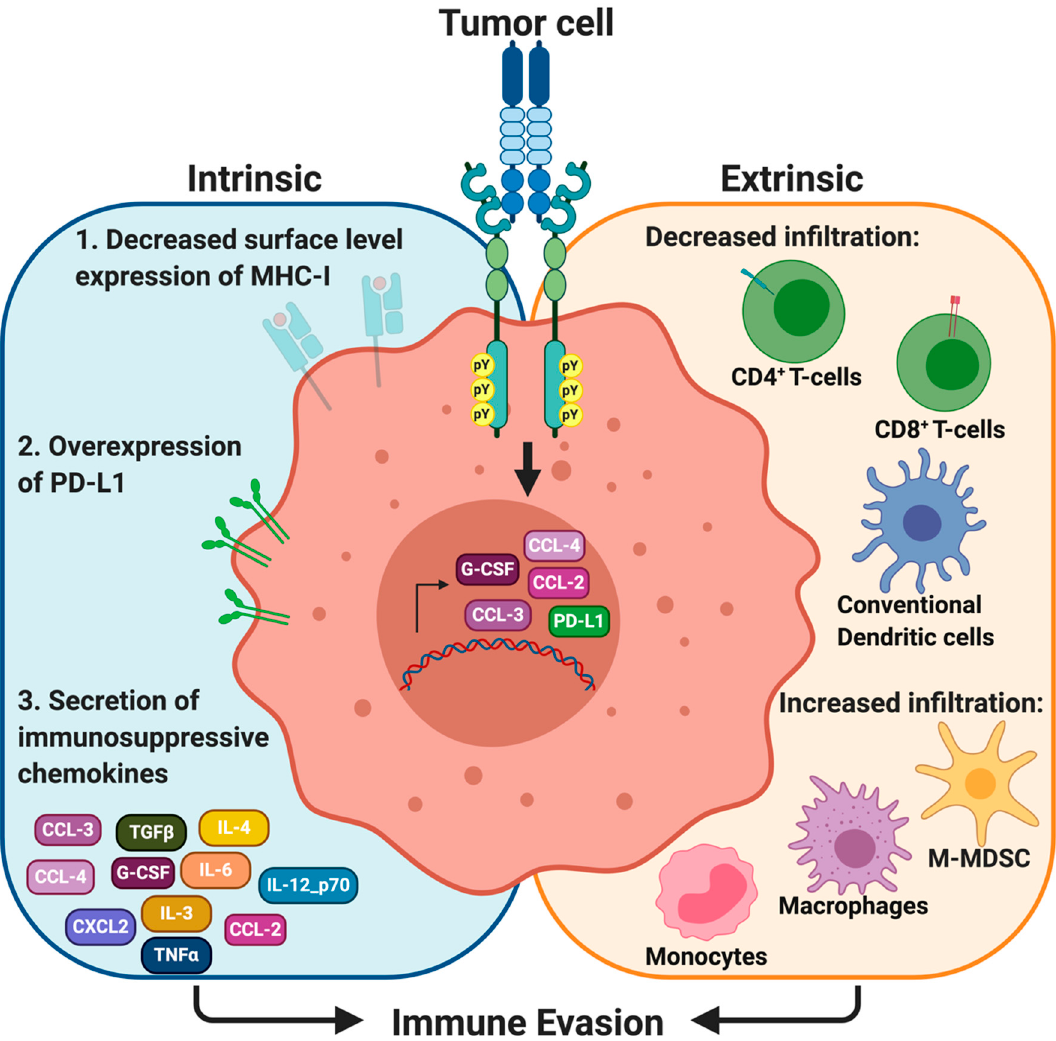
Figure 2. The Gas6 / Axl signaling promotes the immunosuppressive tumor microenvironment. Axl signaling modulates surface level expression of major histocompatibility complex I (MHC-I) and programmed death ligand-1 (PD-L1) on neoplastic cells. The Gas6 / Axl signaling also promotes secretion of immunosuppressive chemokines, including CCL3-5, G-CSF, IL-3, IL-4, IL-6, IL-12_p70, TGF β , and TNF α . In the context of the tumor immune microenvironment, the Gas6 / Axl signaling promotes infiltration of macrophages, monocytes, and myeloid-derived suppressor cells (MDSCs), but decreases infiltration of CD4 + and CD8 + T-cells, and conventional dendritic cells in the tumor.